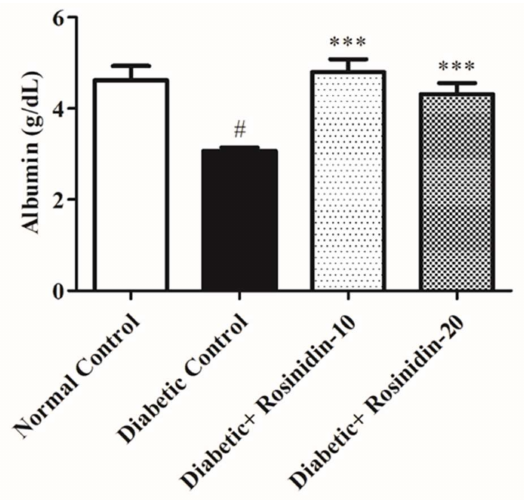
Figure 7. Effect of rosinidin on albumin against that of STZ-induced diabetic rats ( n = 6). Values are expressed as mean ± SEM. # p < 0.05, normal control vs. diabetic control; *** p < 0.001, diabetic control vs. rosinidin-10,